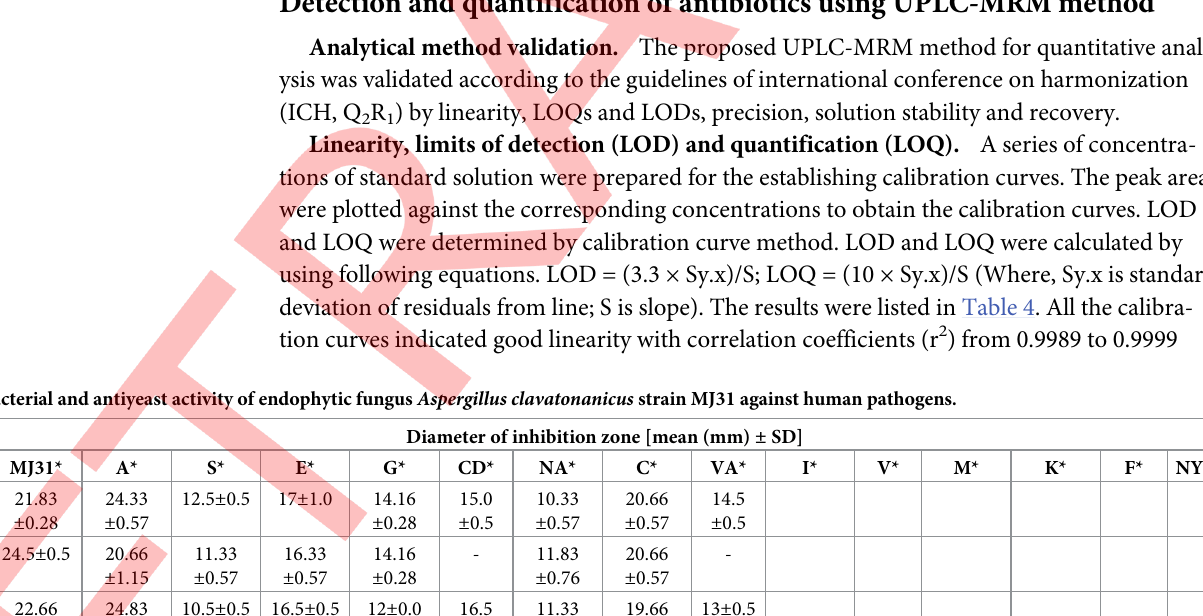
PKSs. NRPS gene was also detected with the amplified product size of 300 bp (Fig 7). Annota- tion of the sequences using ORF finder and BLASTx analysis of PKSI revealed the sequence similarity of 92% and 81% sequence similarity for PKSI and NRPS genes respectively. The sequences were deposited in GenBank with accession numbers KY114487 and KY114488.